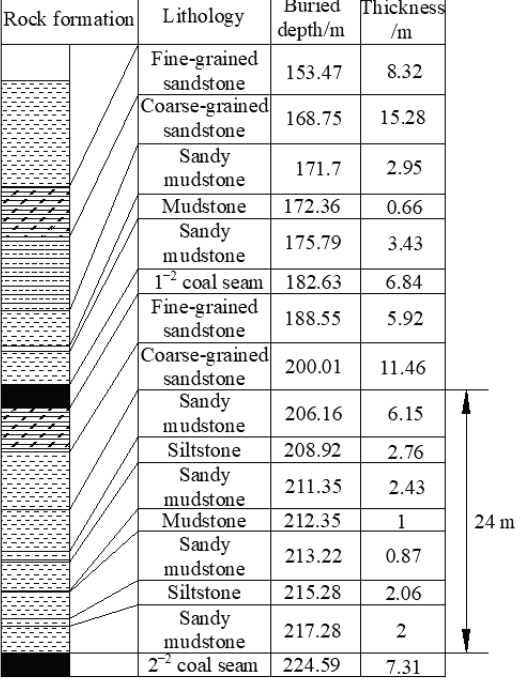
Figure 2. Histogram of No.b280 borehole.